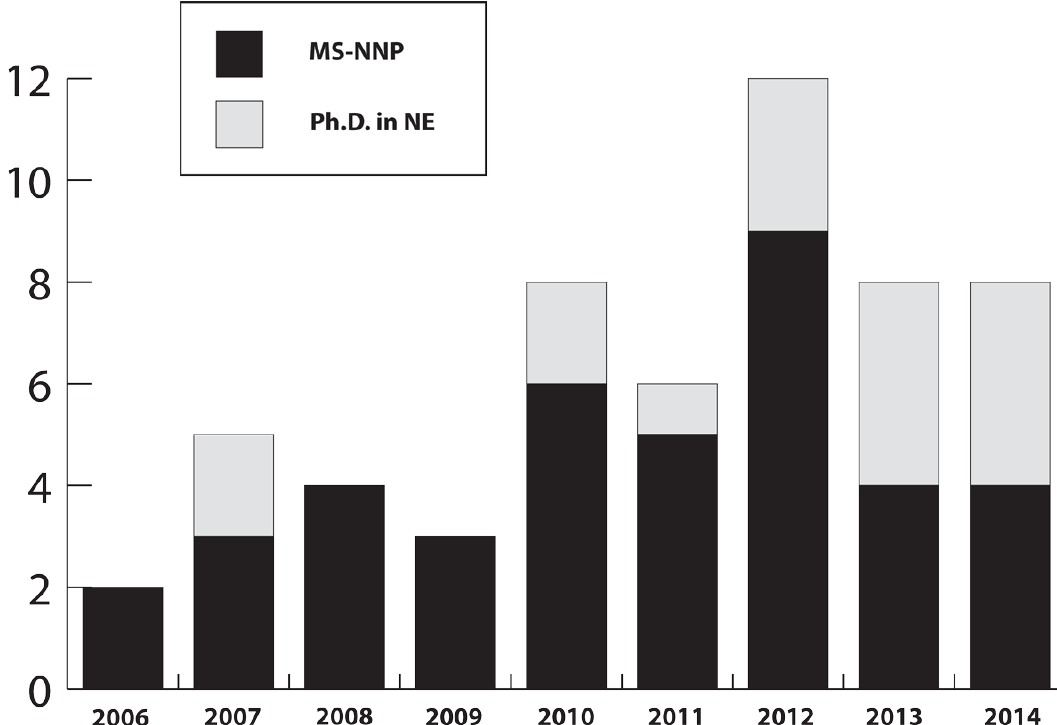
Figure 1. Number of M.S. and Ph.D. degrees with nuclear nonproliferation (NNP) specialization awarded on NSSPI- funded